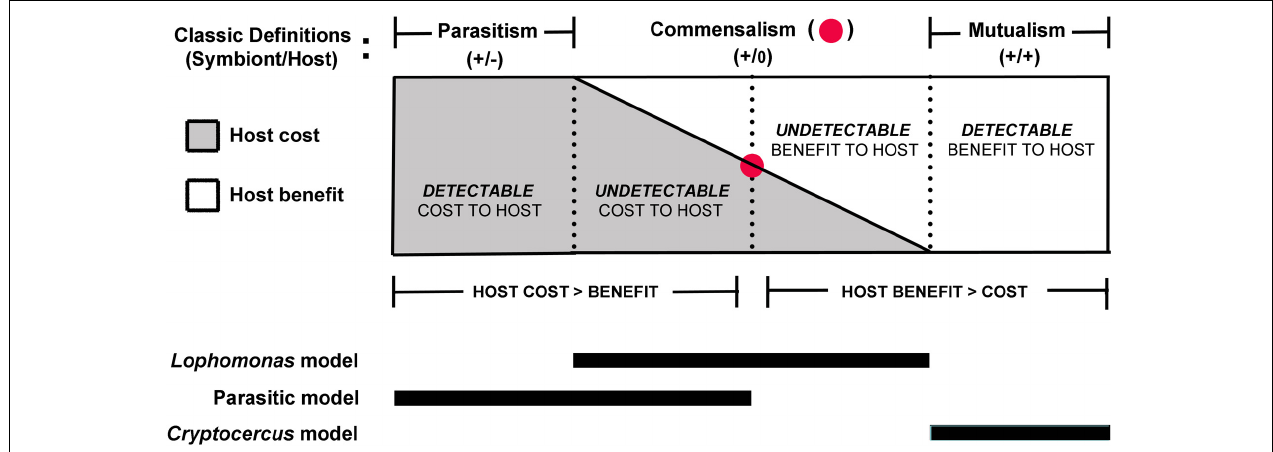
FIGURE 3 | Spectrum of symbiotic interactions in proposed models of the relationship of cockroaches to their gut flagellates. Parasitism and mutualism bookend an unprovable theoretical interval (commensalism) within the continuum of the symbiotic spectrum (see Zapalski, 2011); undetectable effects do not lend themselves to empirical proof. Because the protists always benefit from the relationship, the most relevant criteria for classification of the interaction are detectable damage or benefit in the host, described by the damage response framework (Casadevall and Pirofski, 2015). Regardless of the degree of detectable or undetectable negative impact on the host in the parasitic model, a change to vertical transmission would have strong potential to push the interaction to the mutualistic end of the